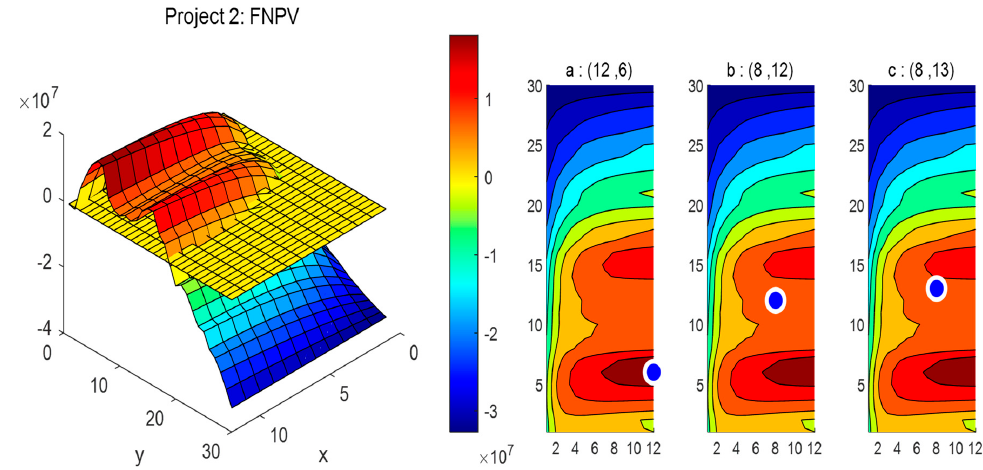
28 of 32 Figure A3. Selected mean value decrease scenario of gas prices.